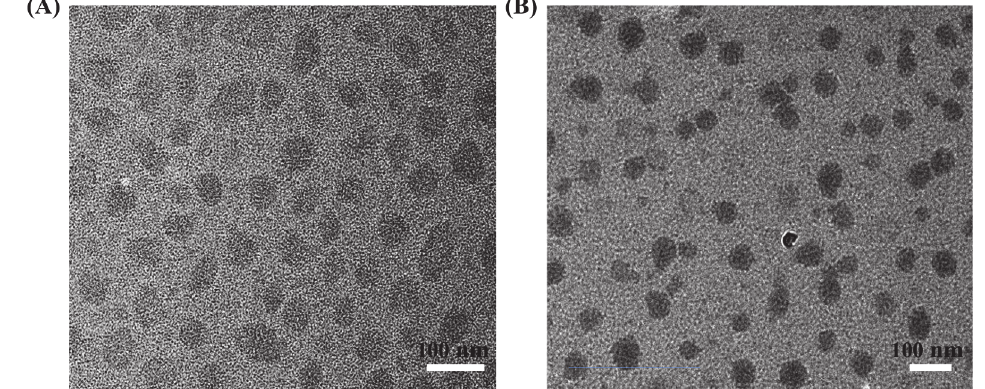
Figure 5. TEM images of Supramolecular nanomicelle ( A ) B 1 ‐ QAS@MH ‐ NO, ( B ) B 7 ‐ QAS@MH ‐ NO.